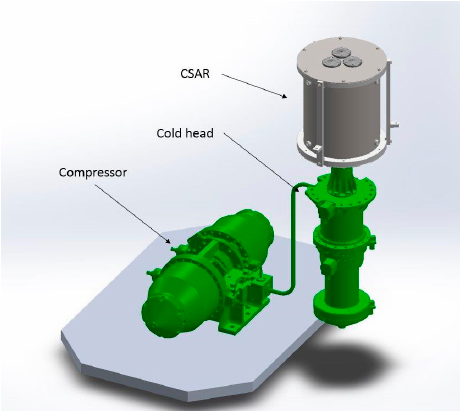
Figure 5. Schematic diagram showing overall layout for the TRUTHS cryogenic solar absolute radiometer (CSAR).